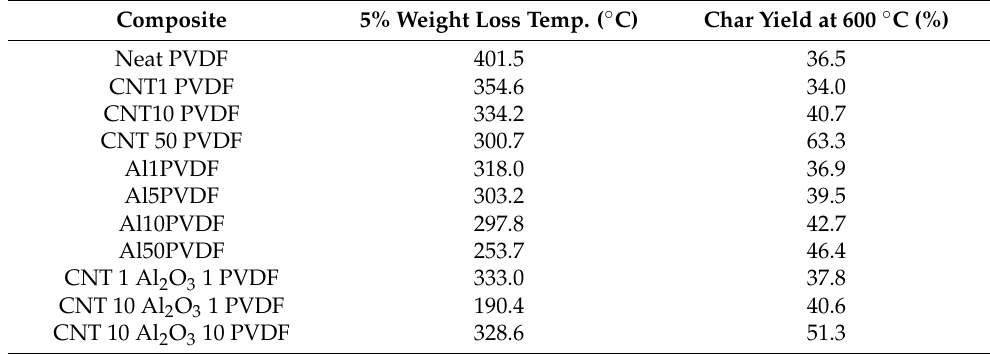
Table 3. Summary of TGA results showing 5% weight loss temperature and char yield at 600 ◦ C.